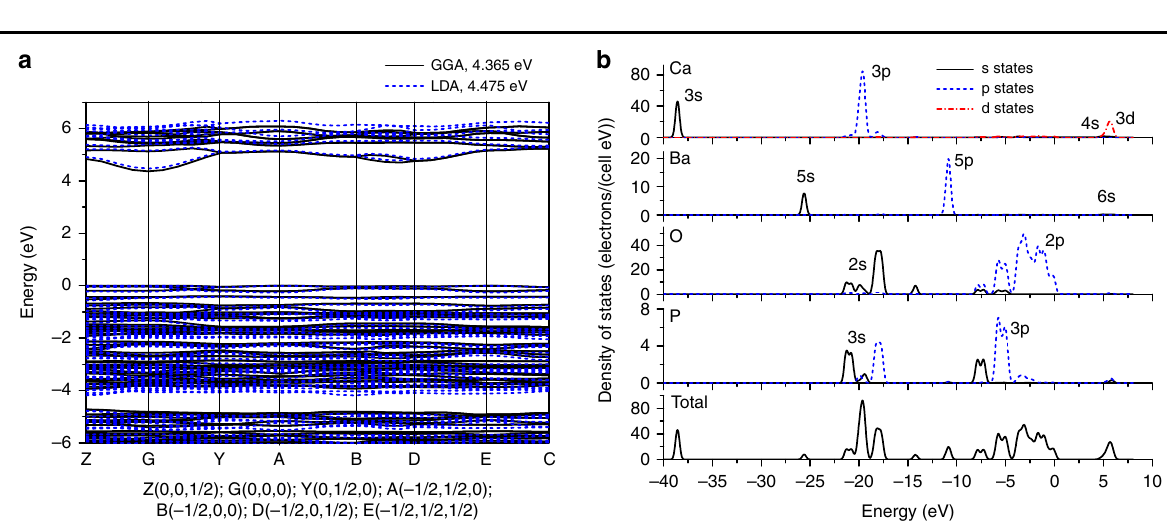
Fig. 2 Electronic properties of Ca 6 Ba(PO 4 ) 4 O:Mn 5 + . a The electronic band structure of Ca 6 Ba(PO 4 ) 4 O. b Partial and total density of states of